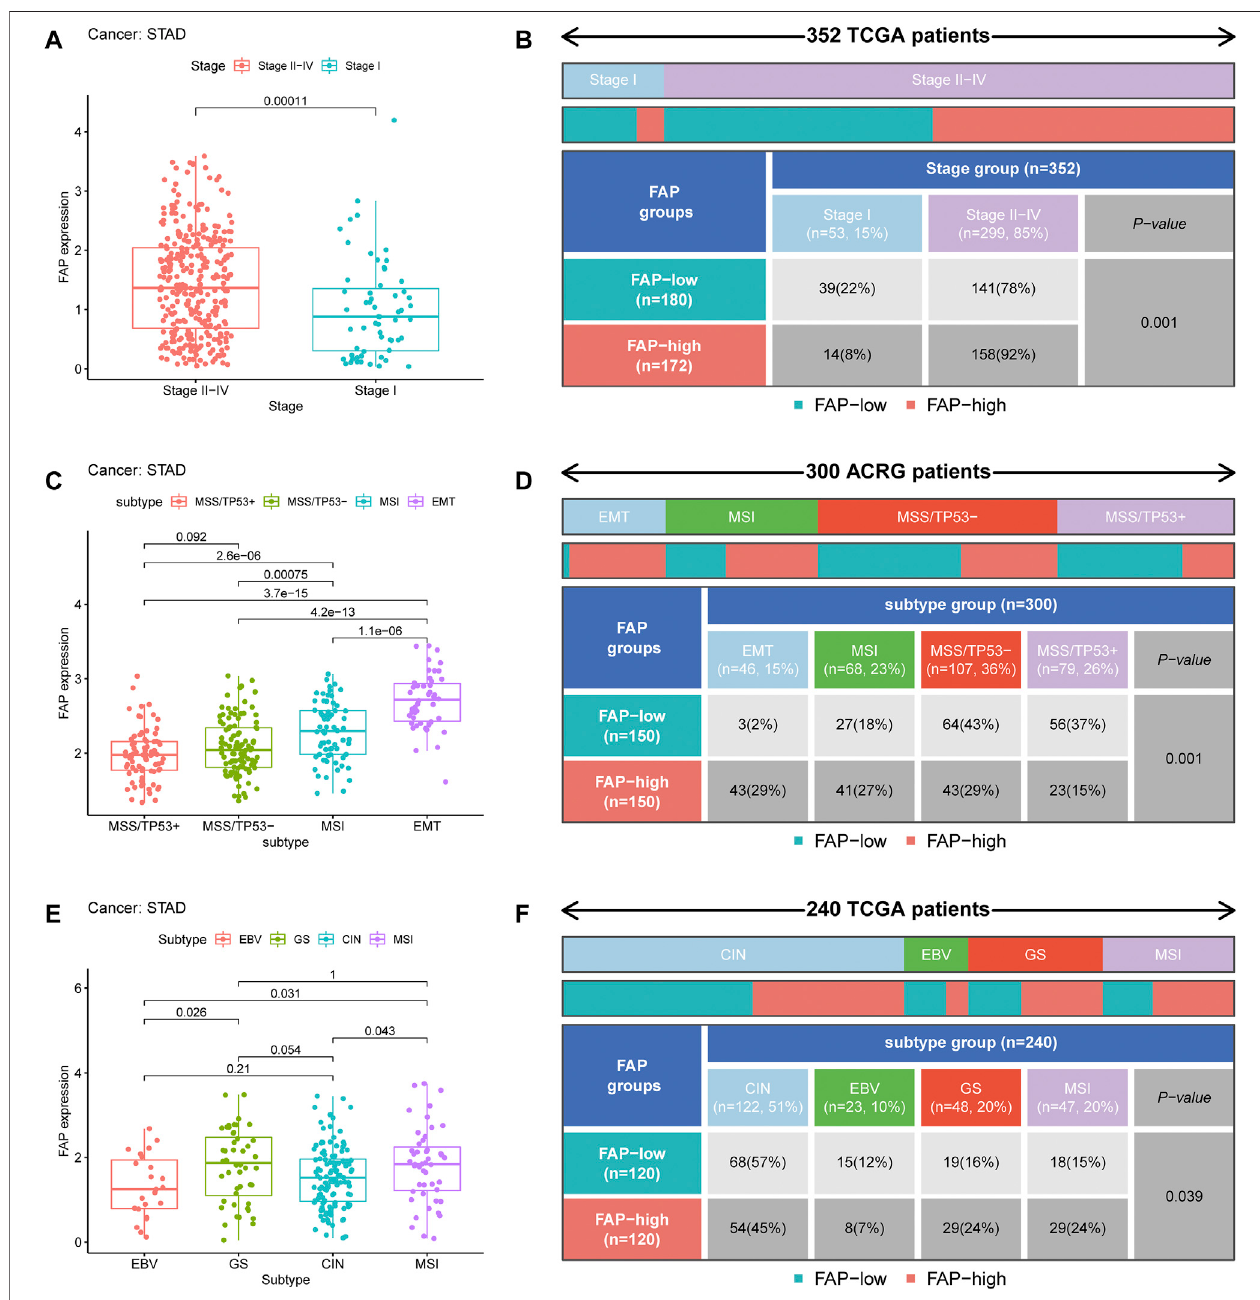
FIGURE 2 | Clinical correlation of FAP. (A) FAP expression level in different STAD stages. (B) Heat map and table showing the distribution of STAD stages among thedifferentFAPexpressionlevels. (C) FAPexpressionlevelsindifferentACRGmolecularsubtypes. (D) HeatmapandtableshowingthedistributionofACRGmolecular subtypes among the different FAP expression levels. (E) FAP expression level in different TCGA molecular subtypes. (F) Heat map and table showing the distribution of TCGA molecular subtypes among the different FAP expression levels.